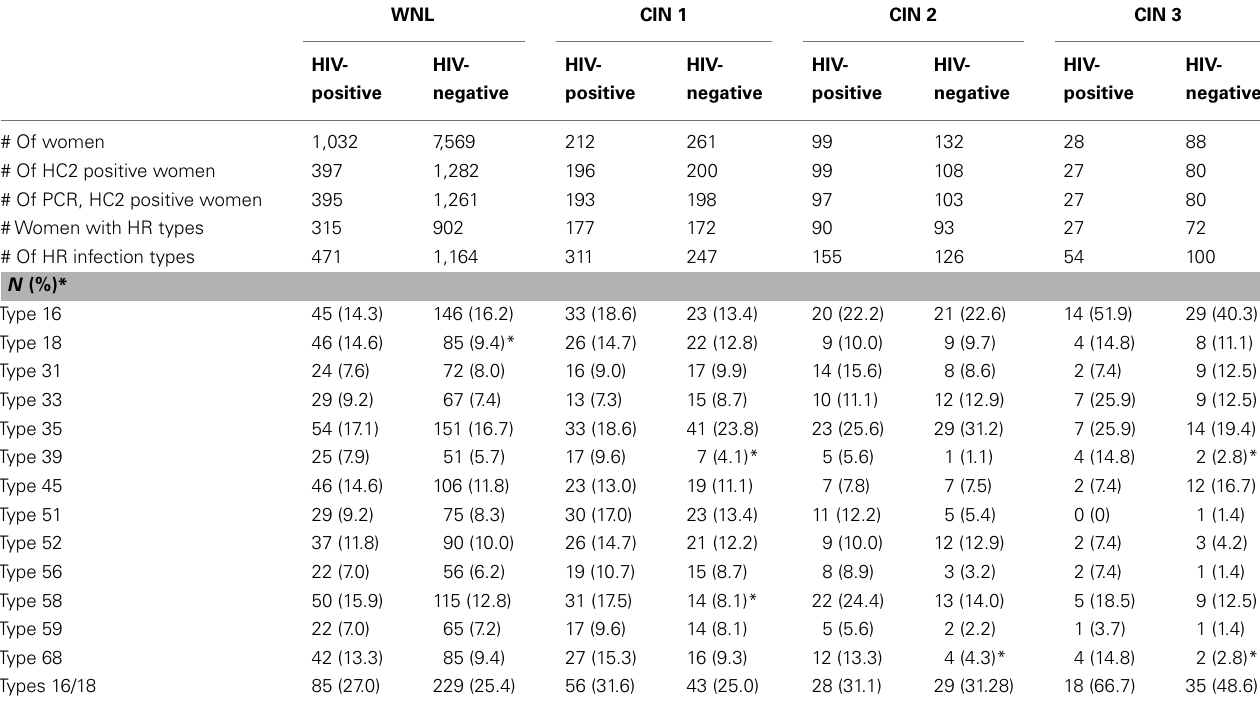
Table 3 | Distribution of specific high-risk HPV genotypes among 609 HIV-positive women and 1,239 HIV-negative women with a high-risk genotype detected by